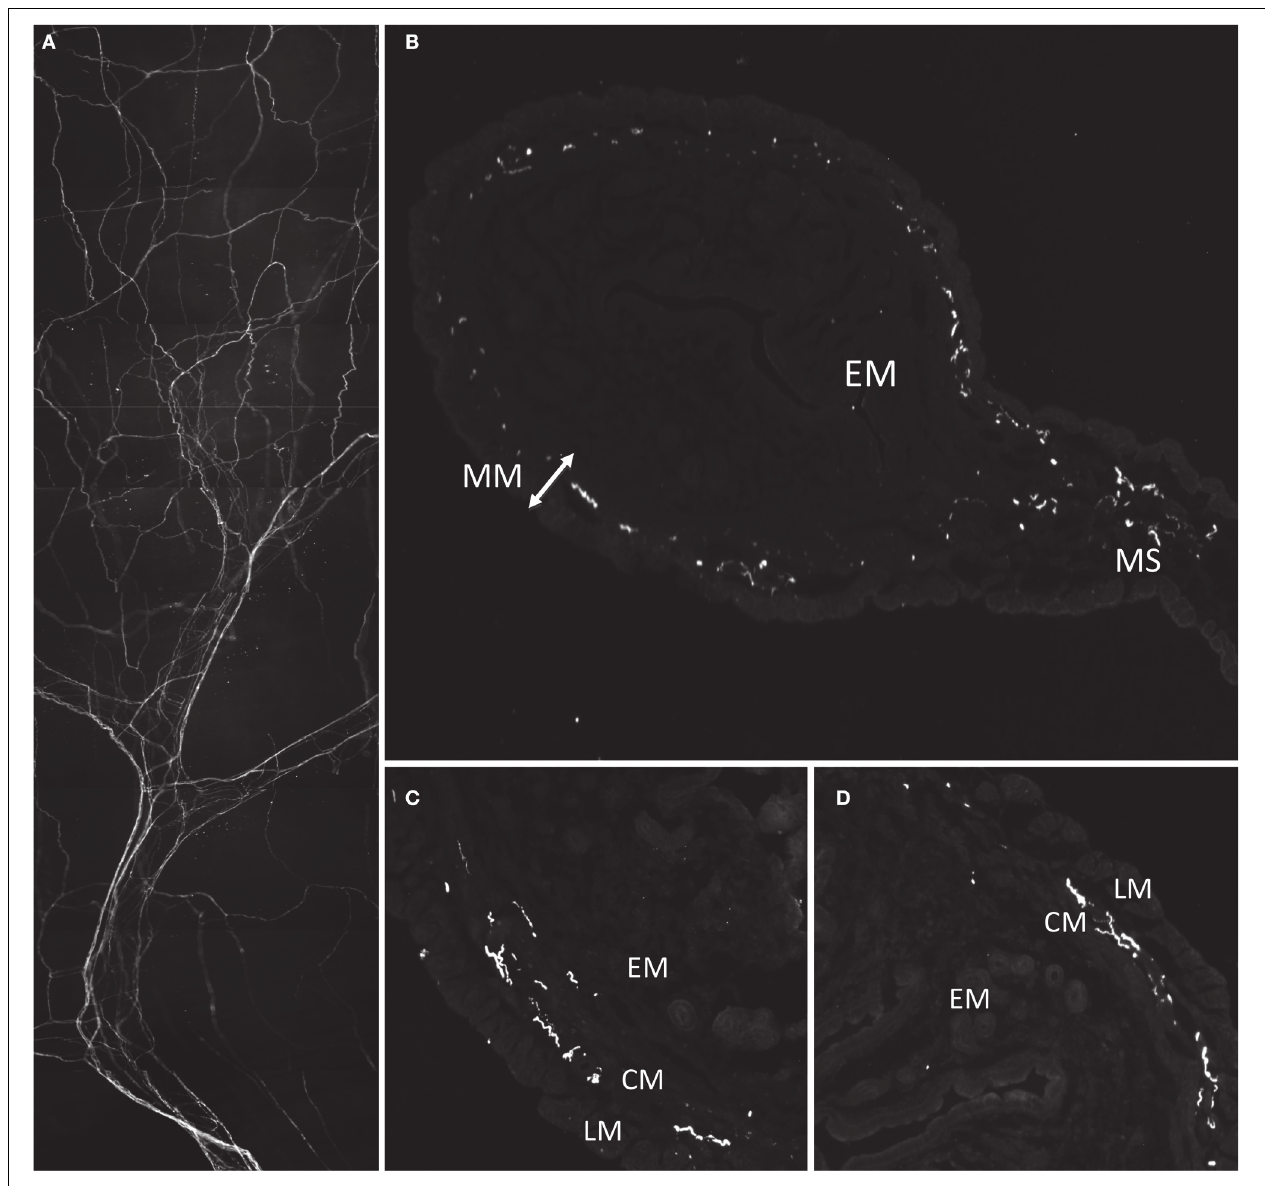
FIGURE 4 | Morphology and localization of nerve fibers in mouse uterus labeled with antibodies against CGRP. (A) Gross morphology of nerve fiber bundles entering through mesenteric vasculature. (B) Cryosection of uterine horn showing localization of fibers in